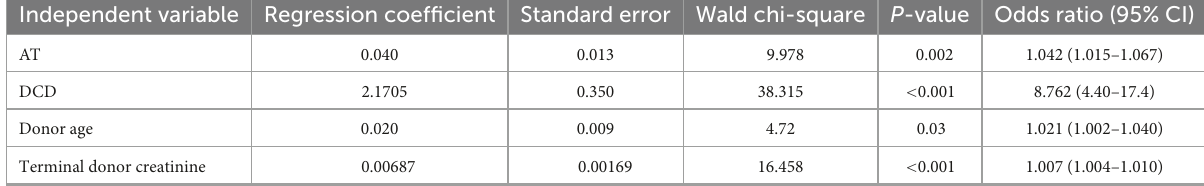
TABLE 3 Determinants of DGF by binary logistic regression